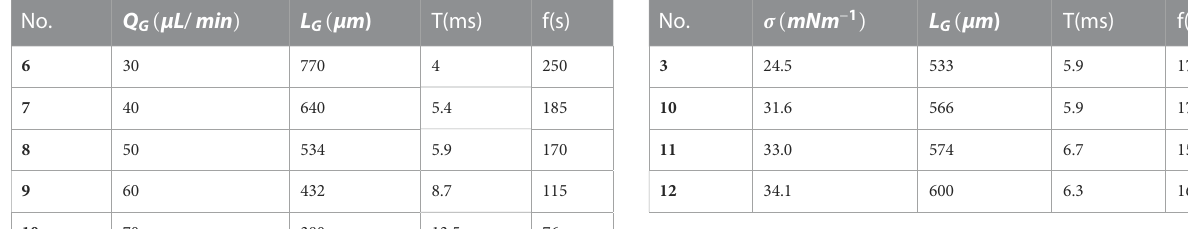
TABLE 5 Generation features of different liquid fl ow rate. No.